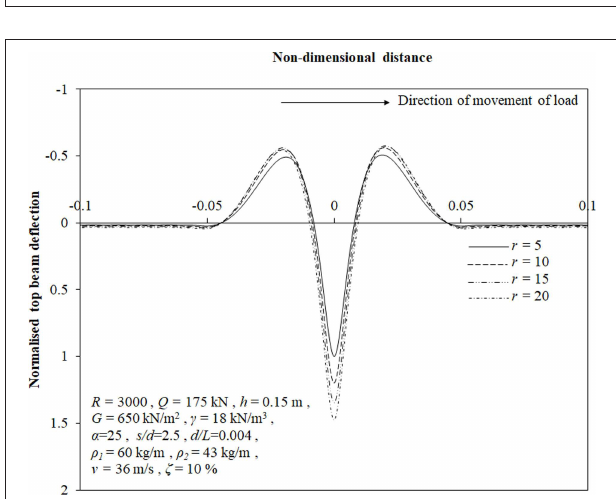
FIGURE 9 | Deflection profile of top beam for various values of α